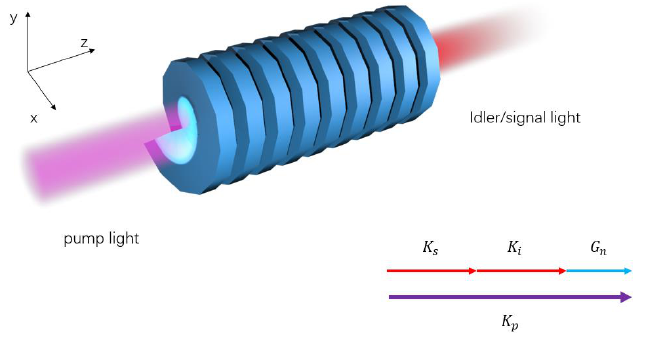
Figure 1. Schematic of SPDC in a 3D spiral NPC and the corresponding QPM condition. Here, ϕ = arctan ( y/x ) is the azimuthal angle, l c is the topological charge of the NPC structure, η denotes the modulation depth of nonlinear coefficients, d 33 is the nonlinear coefficient of LiNbO 3 crystal, and F n = 2 sin n π D are Fourier coefficients corresponding to the reciprocal vector G n = 2 π n Λ z . D is the duty cycle. When D = 0.5, the maximum Fourier coefficient F 1 = 0.635 can be used by involving the first-order reciprocal lattice vectors G 1 .